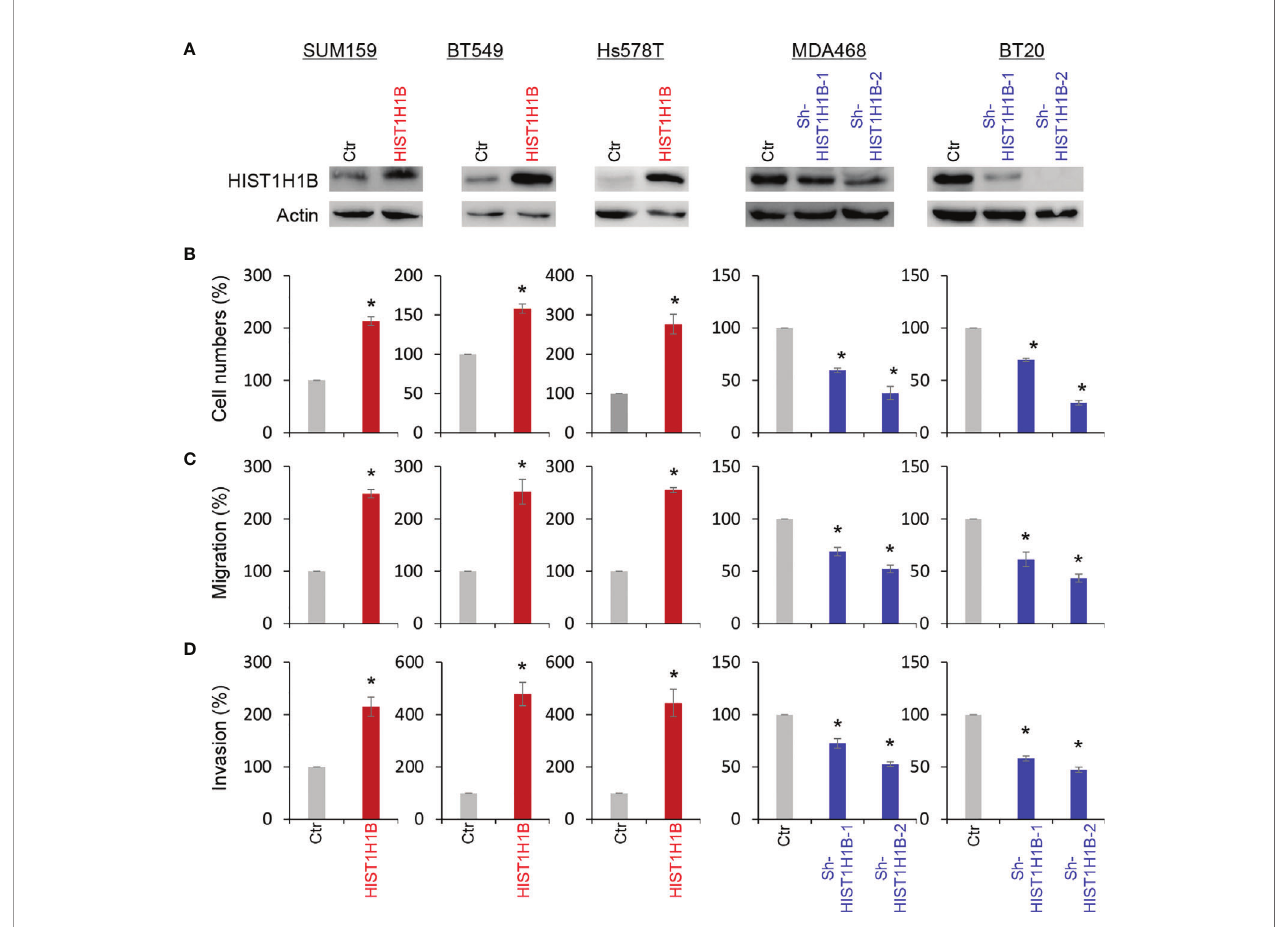
FIGURE 3 | HIST1H1B expression promotes breast cancer cell proliferation, migration and invasion. (A) Expression of HIST1H1B was examined by Western blotting in SUM159, BT549 and Hs578T cells with stable empty vector or HIST1H1B expression as well as MDA468 and BT20 cells with stable empty vector or knockdown of HIST1H1B expression. (B) Proliferation of SUM159, BT549 and Hs578T cells with stable empty vector or HIST1H1B expression (left panel) as well as MDA468 and BT20 cells with stable empty vector or knockdown of HIST1H1B expression (right panel) was analyzed by cell-count assays for 4 days. Data are shown as a percentage of control cells (mean ± SD in two independent experiments) *p < 0.01 by Student's t-test. (C, D) Migration (C) and invasiveness (D) of SUM159, BT549 and Hs578T cells with stable empty vector or HIST1H1B expression (left panel) as well as MDA468 and BT20 cells with stable empty vector or knockdown of HIST1H1B expression (right panel) were analyzed. The percentage of migratory and invasive cells is presented in the bar graph (mean ± SD in three separate experiments). *p < 0.01 by Student's